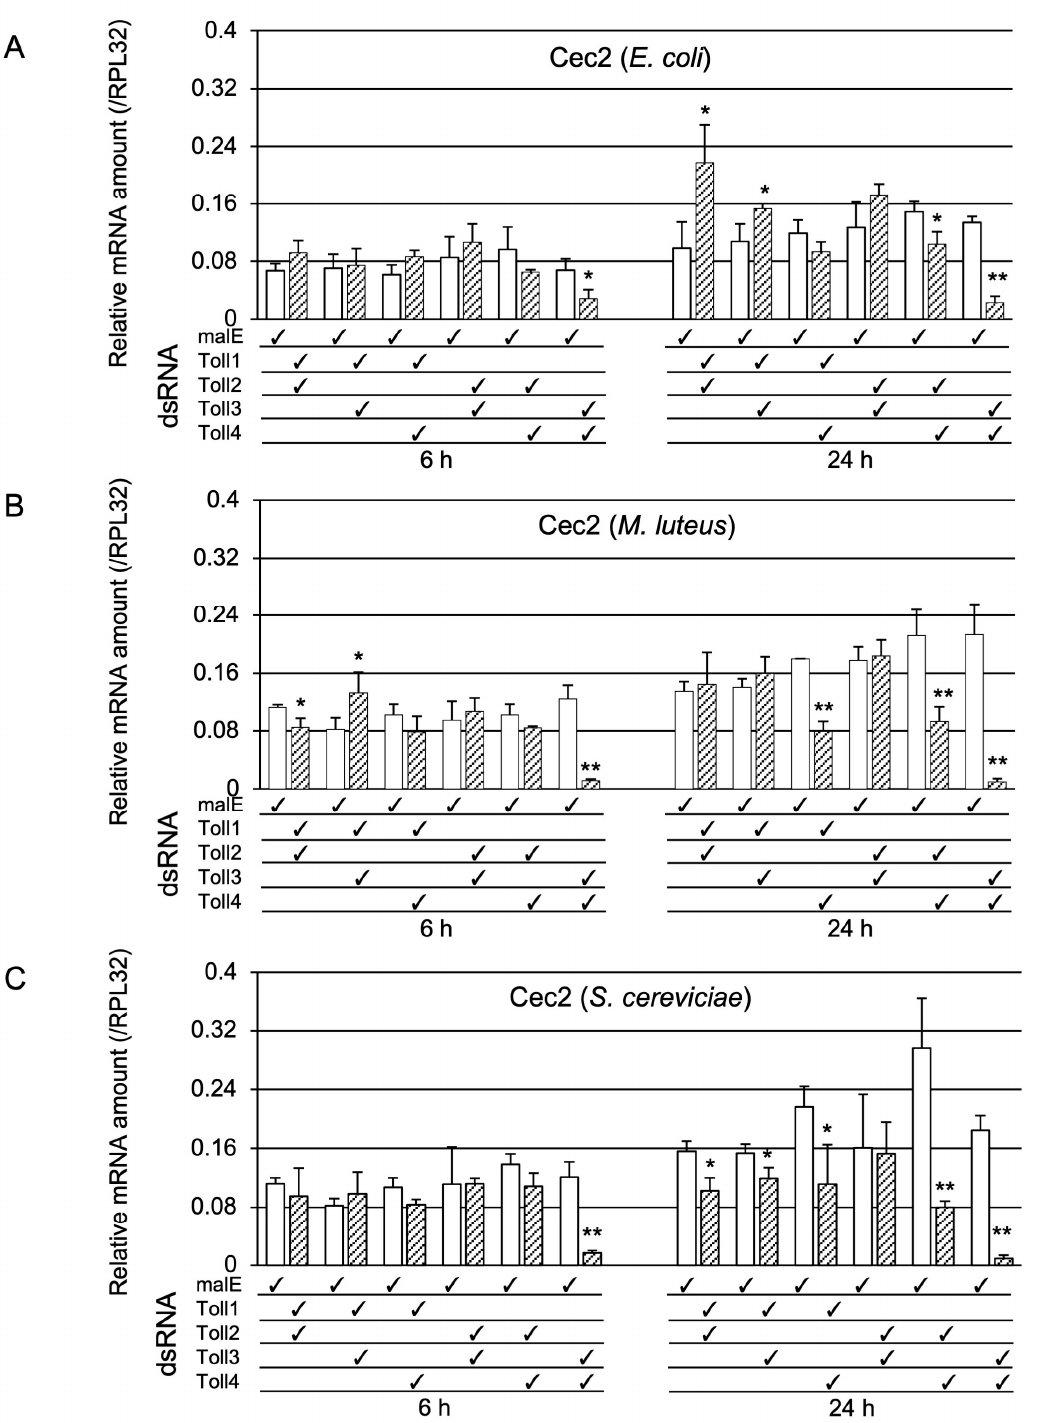
Figure 5. Effect of double knockdown of two Toll genes on Cec2 induction. mRNA levels of Cec2 in pupae treated with malE dsRNA (open bars, control) and pupae with double knockdown (check marked) of Toll1 − 4 genes (shaded bars) after challenge with either Ec ( A ), Ml ( B ), or Sc ( C ). The methods of sample preparation and mRNA level measurement were the same as those described in Figure 3. Experiments with three animals were independently repeated three times, and each column represents the mean ± S.D. Asterisks and double-asterisks indicate p < 0.05 and p < 0.01 compared to Uc samples, respectively, according to Student’s t -test.